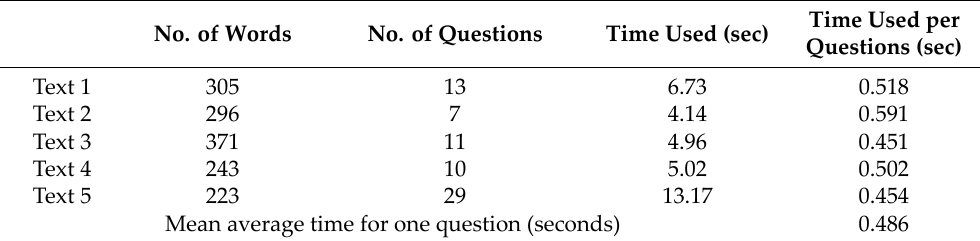
Table 1. Result of response-time test.